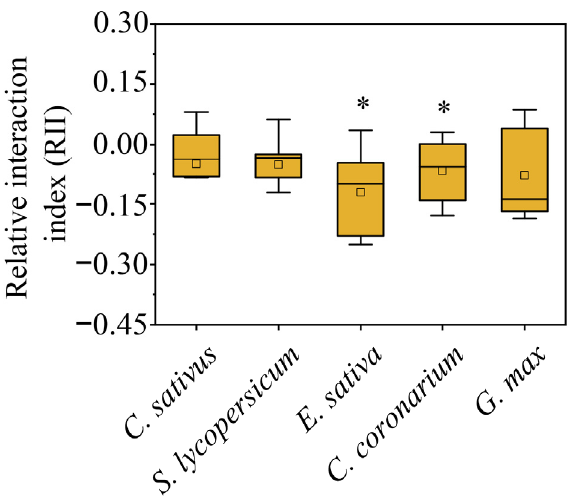
Figure 4. Relative interaction index (RII) for focal plant biomass. * indicates a significant difference between competition and solitary treatment ( p < 0.05).